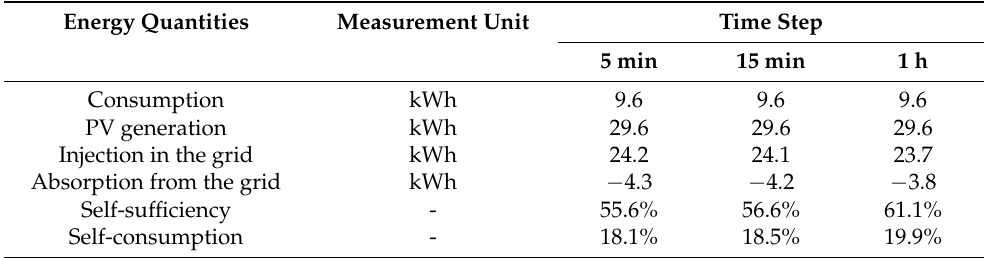
Figure 3. Comparison of power profiles with different time-steps: 5 min ( top ), 15 min (in the middle ), and 1 h ( bottom ). Table 1. Energy quantities related to the example in Figure 3: daily balances.